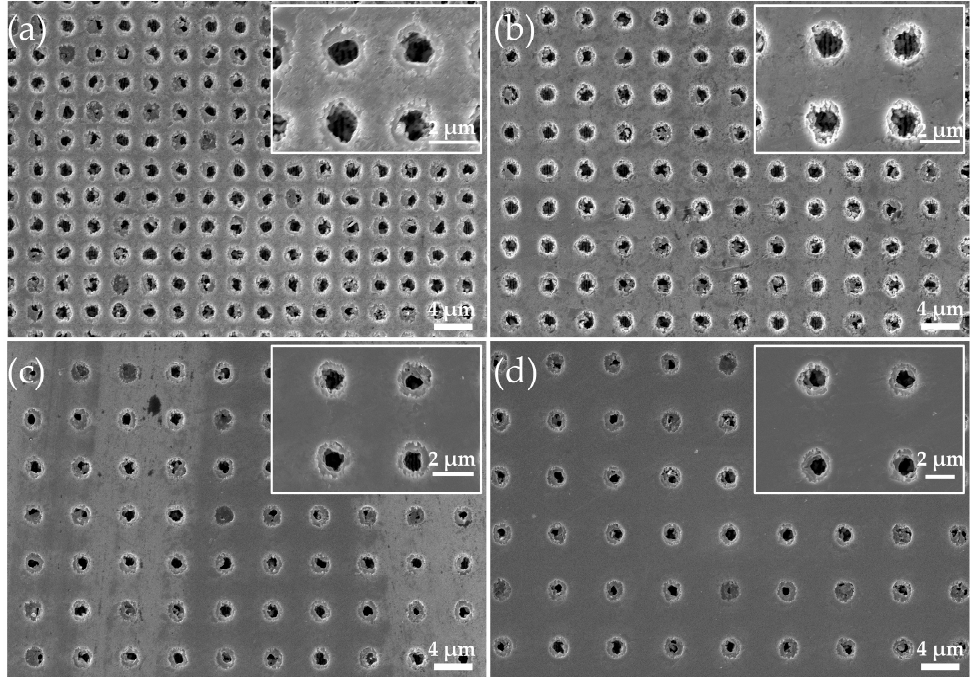
Figure 3. Di ff erent parameters of ARMs (E = 500 nJ; burst 3 mode; ( a ) p = 3 µm, ( b ) 4 µm, ( c ) 5 µm, Figure 3. Different parameters of ARMs (E = 500 nJ; burst 3 mode; ( a ) p = 3 µ m, ( b ) 4 µ m, ( c ) 5 µ m, and ( d ) 6 µm). and ( d ) 6 µ